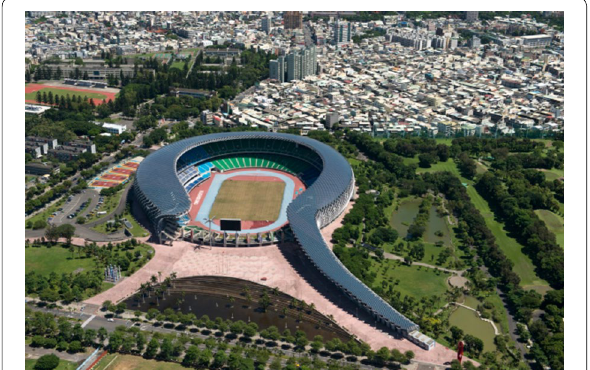
Fig. 19 Kaoshiung stadium, T. Ito, 2009, Kaoshiung, Taiwan (from https